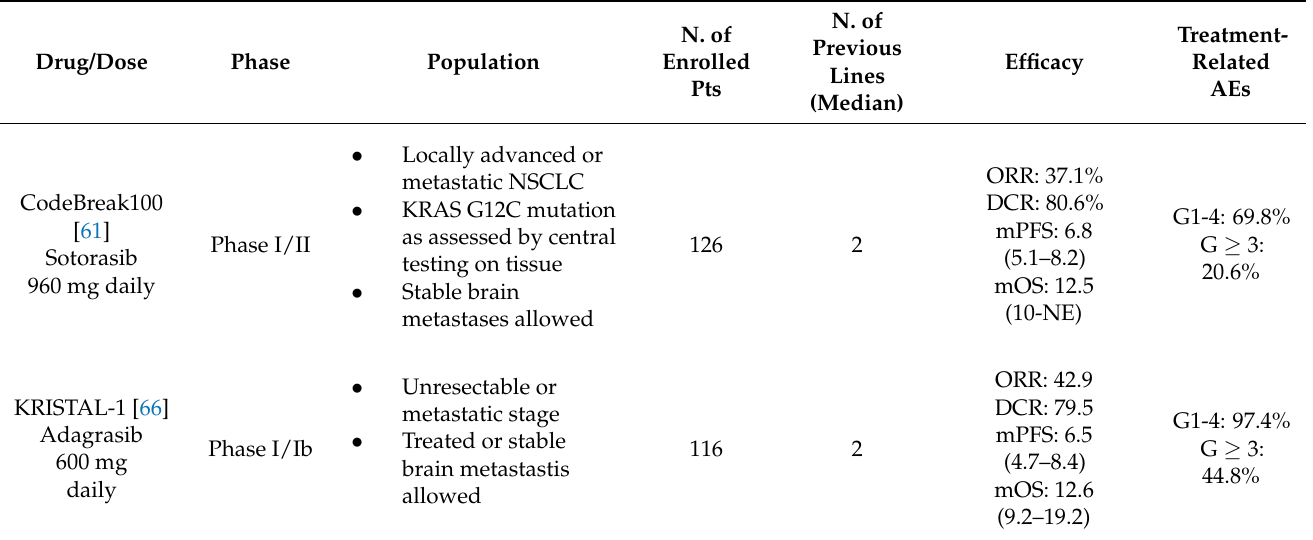
Table 1. Efficacy and safety of treatment of sotorasib and adagrasib in the CodeBreak100 and the KRISTAL-1